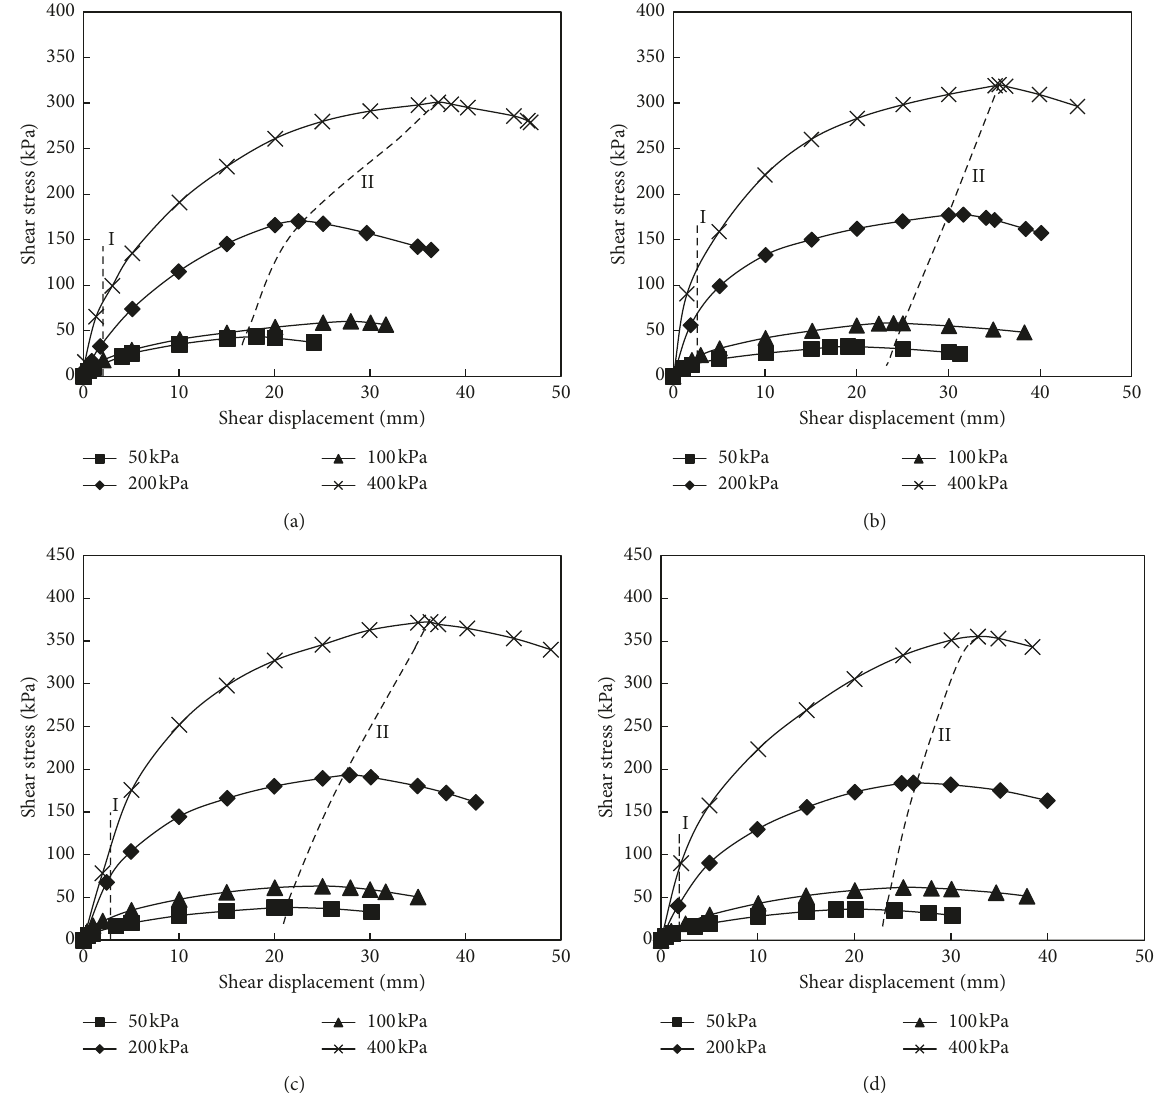
Figure 4: Shear stress-shear displacement of brick powder. (a) 0% rate of reinforcement. (b) 2% rate of reinforcement. (c) 6% rate of reinforcement. (d) 10% rate of reinforcement.